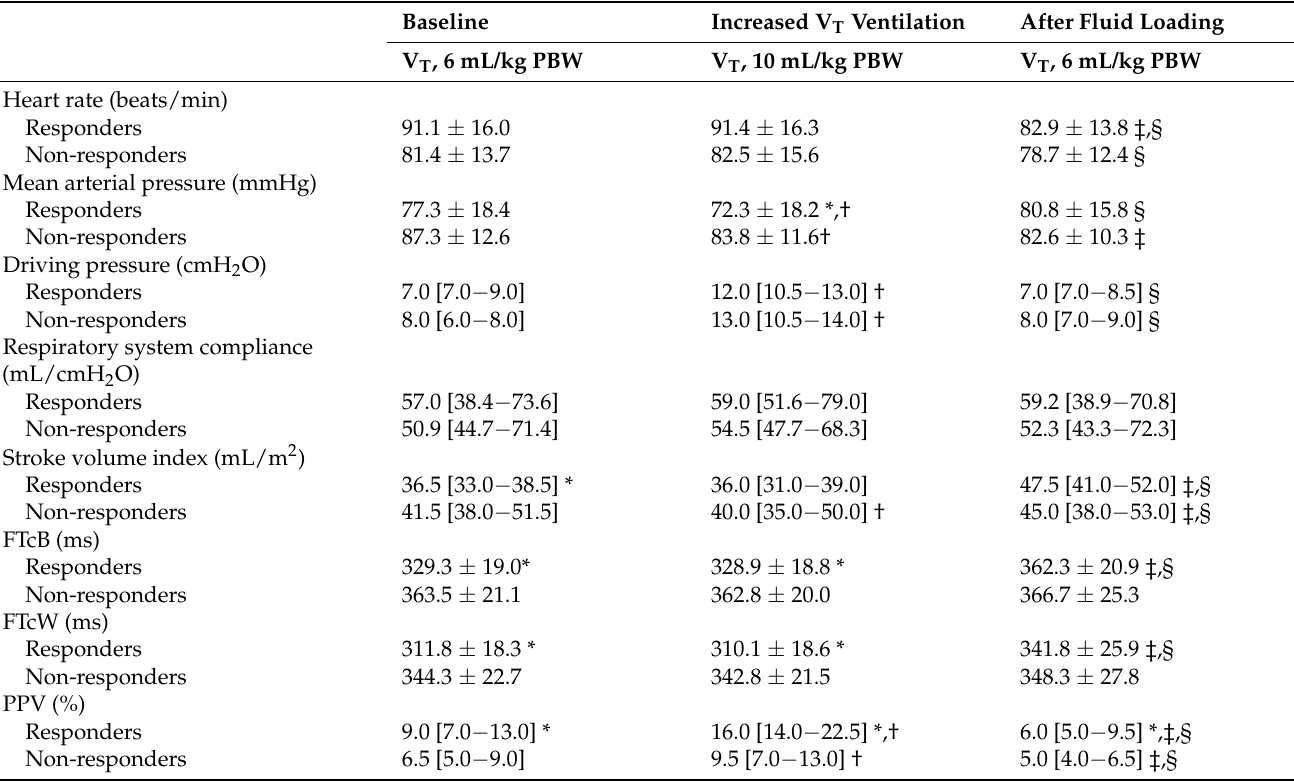
Table 2. Hemodynamic and respiratory variables at baseline, during increased tidal ventilation, and after fluid loading. Baseline Increased V T Ventilation After Fluid